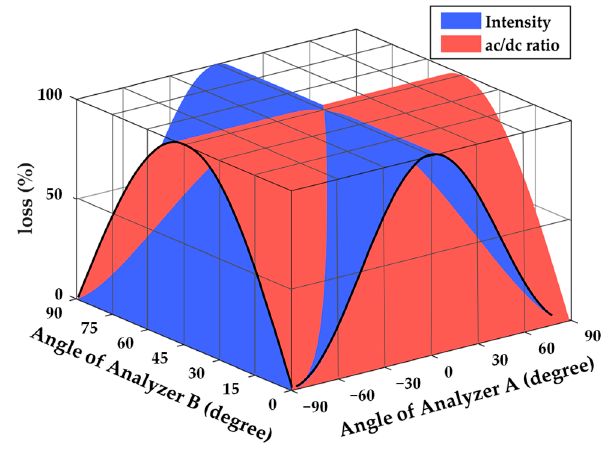
Figure 2. Simulation results of equivalent measurement method.